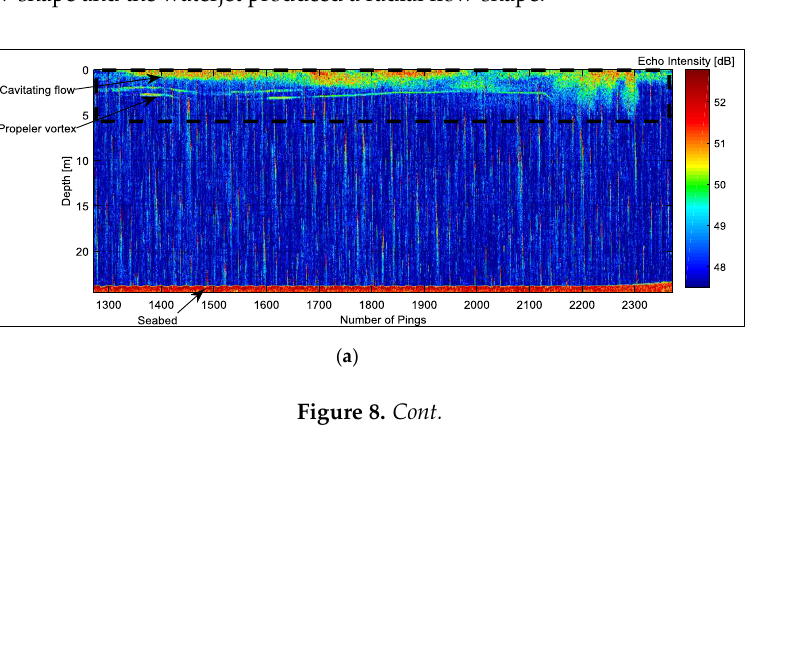
Figure 7. MBS acoustic images of cavitating flow produced by the boat with propeller ( a ) and waterjet thruster ( b ). Both flows reached depths close to 10 m and lasted about 90 s. The propeller boat produced a tubular flow-shape and the waterjet produced a radial flow-shape.